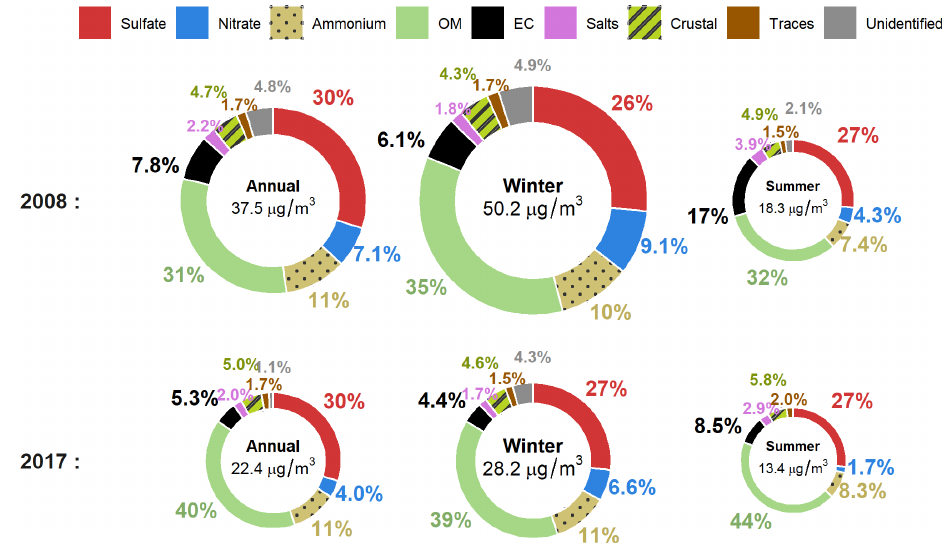
Figure 3. Comparison of average PM 2 . 5 compositions between the starting year (2008) and the ending year (2017) of the decade. In each year, three averages are shown, corresponding to annual, winter, and summer, and the donut size is proportional to the PM 2 . 5